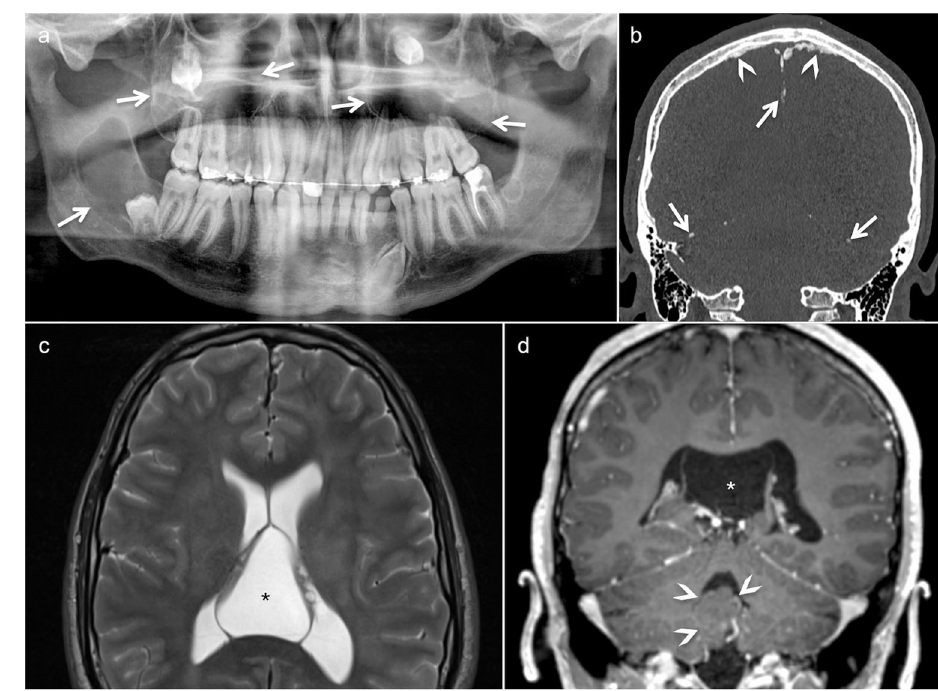
Fig. 4 Typical manifestations of nevoid basal cell carcinoma syndrome (NBCCS) in a 16-year- old boy. a Orthopantomography (OPT) shows cystic lesions of the mandible and maxilla ( arrows ), with unilocular and multilocular pattern and smooth or scalloped borders associated with displaced and unerupted permanent teeth. b Coronal CT scan (bone window) shows ectopiccalcificationsofthe falx cerebri and tentorium cerebelli ( arrows ) and spotted meningeal calcifications ( arrowheads ). Brain MRI reveals a cavum veli interpositi on axial T2 ( asterisk in c ) and coronal contrast-enhanced T1 ( asterisk in d ) and also vermian dysgenesis ( arrowheads in d